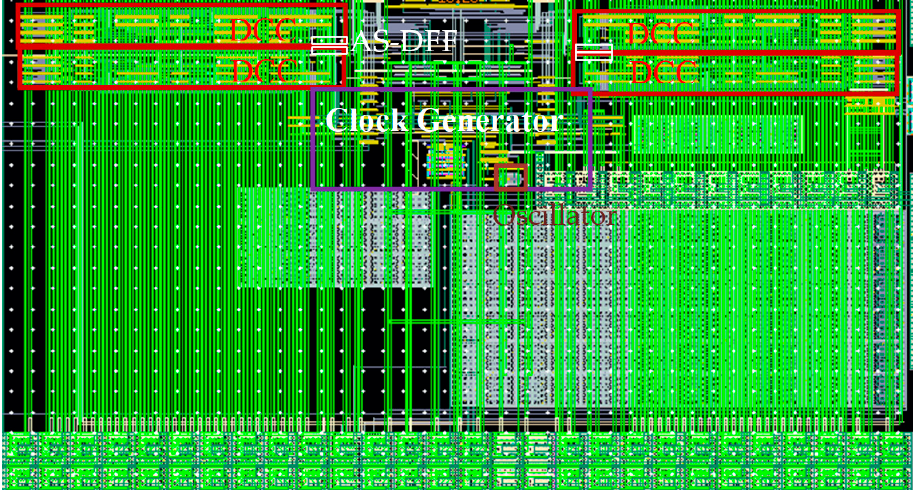
Figure 8. Layout of the proposed AS − DCC.